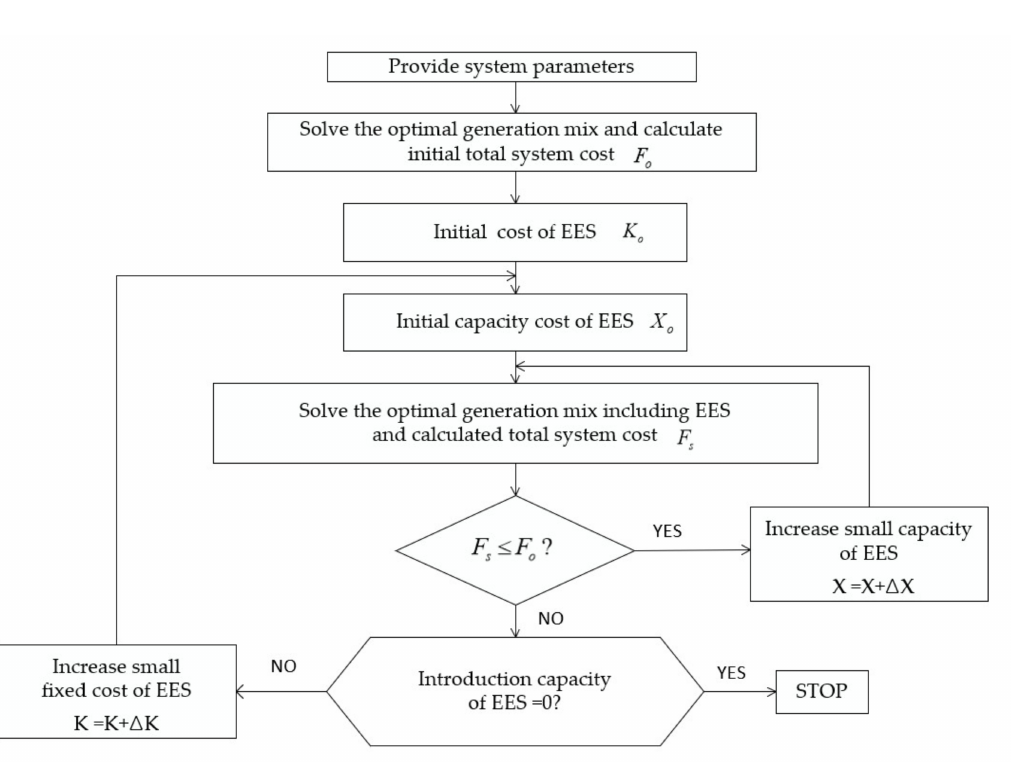
Figure 3. Evaluation algorithm of EES